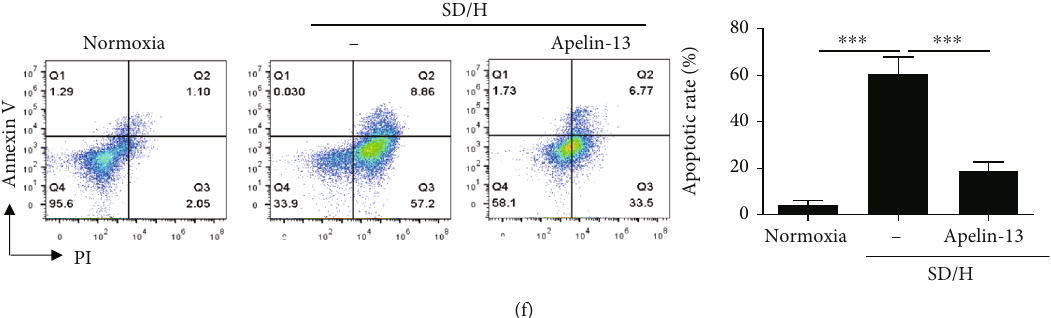
Figure 1: Apelin-13 pretreatment inhibits SD/H-induced mitochondrial fragmentation and apoptosis of MSCs. (a) CCK-8 assay showed the cell viability of MSCs with or without Apelin-13 (0.01, 0.05, 0.1, 0.5, and 1nM) pretreatment for 24 hours under normoxic or SD/H conditions. (b) CCK-8 assay showed the cell viability of MSCs with or without 0.1nM Apelin-13 pretreatment for 6, 12, 24, or 36 hours under normoxic or SD/H conditions. (c) Representative images of MitoTracker staining and quantitative analysis of the mitochondrial number and mean mitochondrial area in MSCs and Apelin-13-pretreated MSCs under normoxic or SD/H conditions. (d) Western blotting and quantitative analysis of the protein level of Mfn1/2 and p-Drp1 ser616 in MSCs and Apelin-13-pretreated MSCs under normoxia or SD/H challenge. (e) Representative images of Mito-Sox staining and quantitative analysis of ROS generation in MSCs and Apelin-13-pretreated MSCs under normoxic or SD/H conditions. (f) Representative images of Annexin V/PI staining and quantitative analysis of the apoptotic rate in MSCs and Apelin-13-pretreated MSCs under normoxic or SD/H conditions. n = 3 biological replicates for each group. Data are expressed as mean ± SD . ∗ p < 0 : 05 , ∗∗ p < 0 : 01 , ∗∗∗ p < 0 : 001 . ns, not signi fi